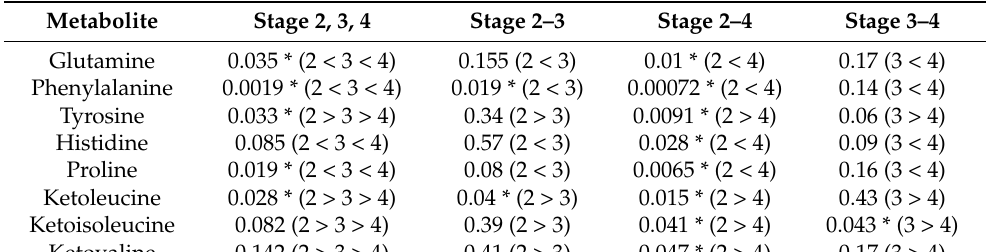
Table 4. Evaluation of changes of relative metabolites levels in blood plasma in patients in Stages 2, 3, and 4, p -values obtained by Kruskal–Wallis test for multiple comparisons with post hoc Dun’s test for pairwise comparison for Stages 2, 3, and 4. The direction of changes is indicated in parenthesis, * significant difference.